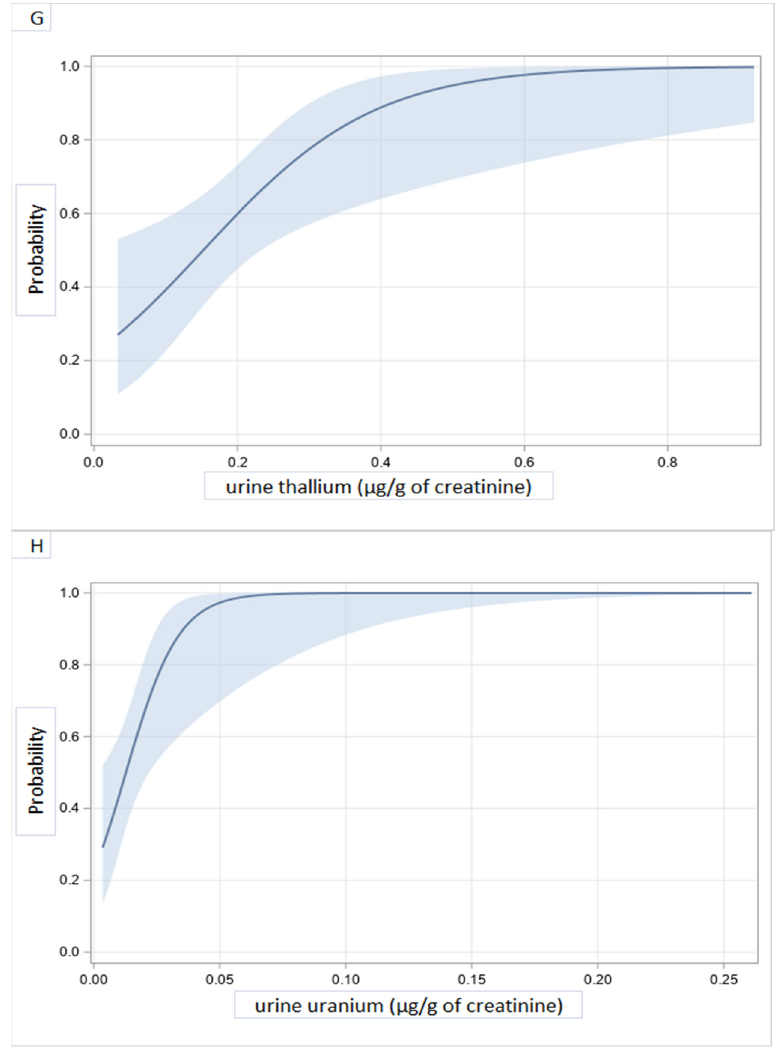
Figure 3. Illustrative predicted probabilities of dilated cardiomyopathy as a function of heavy metals concentrations in urine: chromium ( A ), copper ( B ), zinc ( C ), selenium ( D ), cadmium ( E ), antimony ( F ), thallium ( G ), and uranium ( H ).